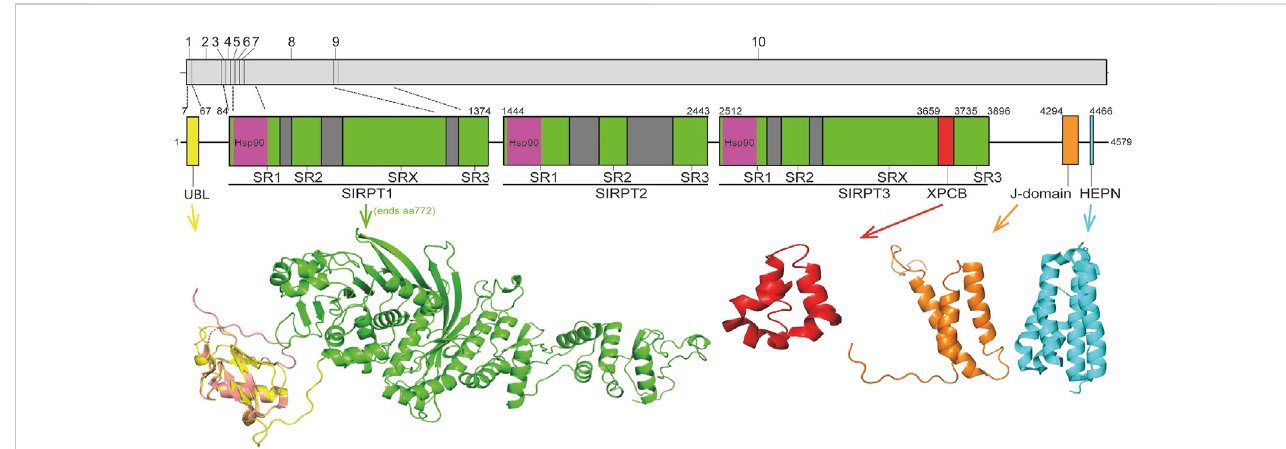
FIGURE 1 Schematicrepresentationofsacsindomainstructure.Regionsofsacsinwithhomologytodomainsofotherproteinsareindicated(numberscorrespond to amino acid position) with domains where structure has been solved or modelled shown (UBL, Hsp90, XPCB, J-domain and HEPN). The internal repeats of sacsin are also indicated and the structure of the sacsin transcript is also shown (with exons numbered and dotted lines indicating exons encoding different regions of sacsin). The crystal structure of the sacsin UBL (PDB 5VSX; salmon) is superimposed on the AlphaFold predicted UBL structure